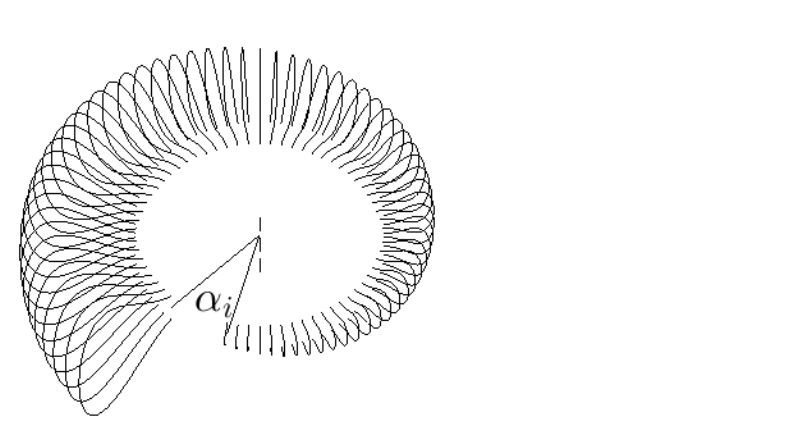
Figure 8. Baffle tongue angle controlled by the design variable α i . Table 3. List of the design variables (DVs) with the baseline values, the minimum/maximum values during the surrogate-based optimization (the percentage is computed with respect to the baseline